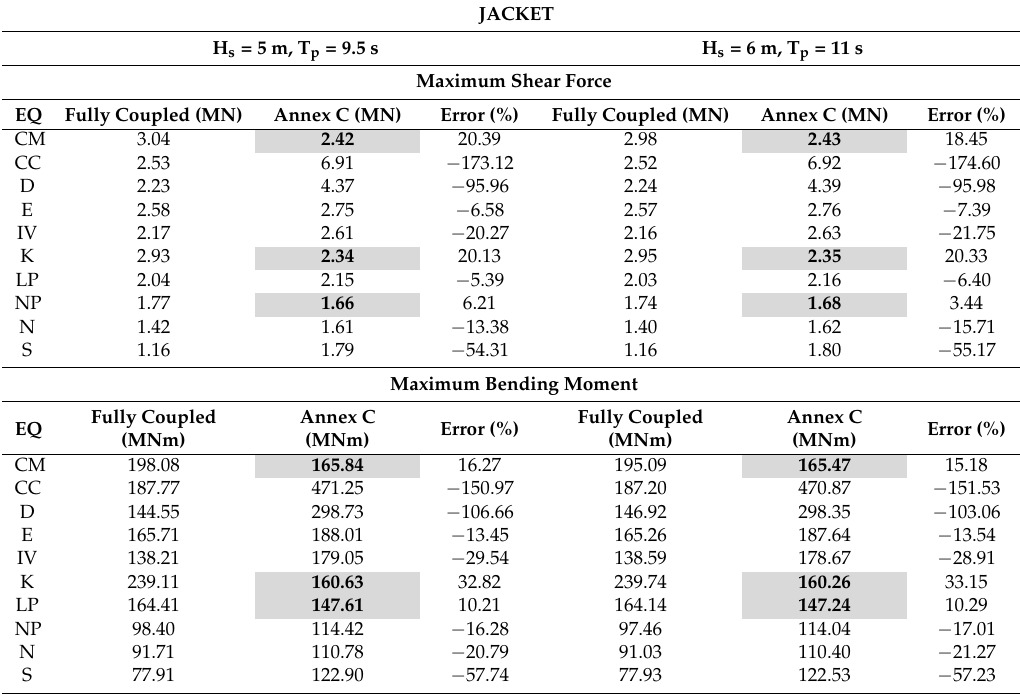
Table 8. Jacket: Shear-force and bending-moment demands at tower base, obtained by Method 3 for emergency shutdown at rated wind speed V = 11.4 m/s and all earthquake records listed in Table 3.